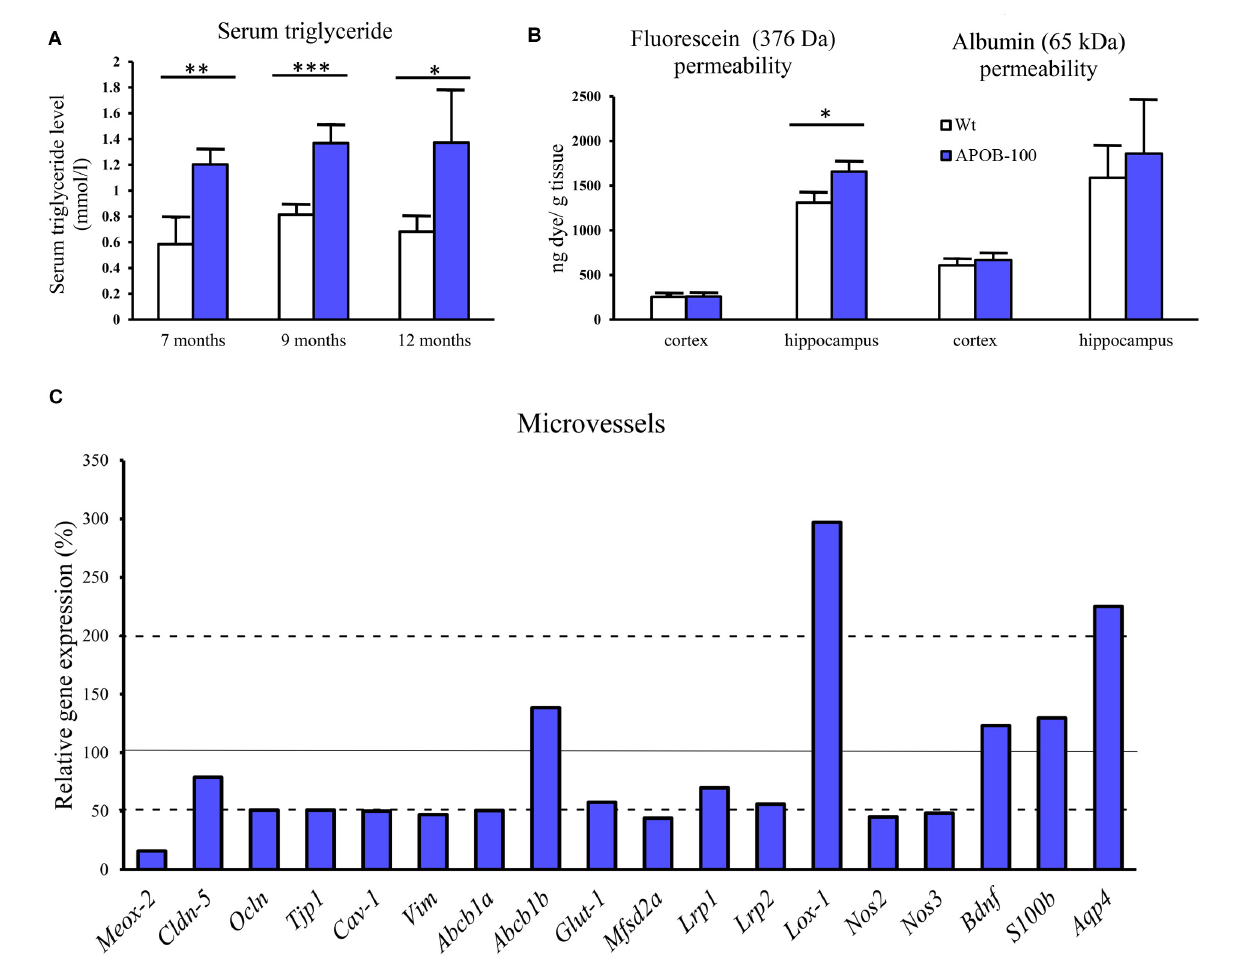
FIGURE 1 | Serum triglyceride levels (A) , BBB permeability for fluorescein and albumin in the brain of hypertriglyceridemic APOB-100 transgenic (APOB-100) and wild-type (Wt) mice (B) , and gene expression analysis of the microvessel fraction from APOB-100 transgenic mice using QPCR (C) . Continuous line indicates the expression level of the corresponding gene in wild-type mice (100%). Dashed lines indicate the levels of significant changes: a 2 fold (200%) increase or an 0.5 fold (50%) reduction in gene expression. ∗∗∗ P < 0.001, ∗∗ P < 0.01, ∗ P < 0.05, compared with Wt